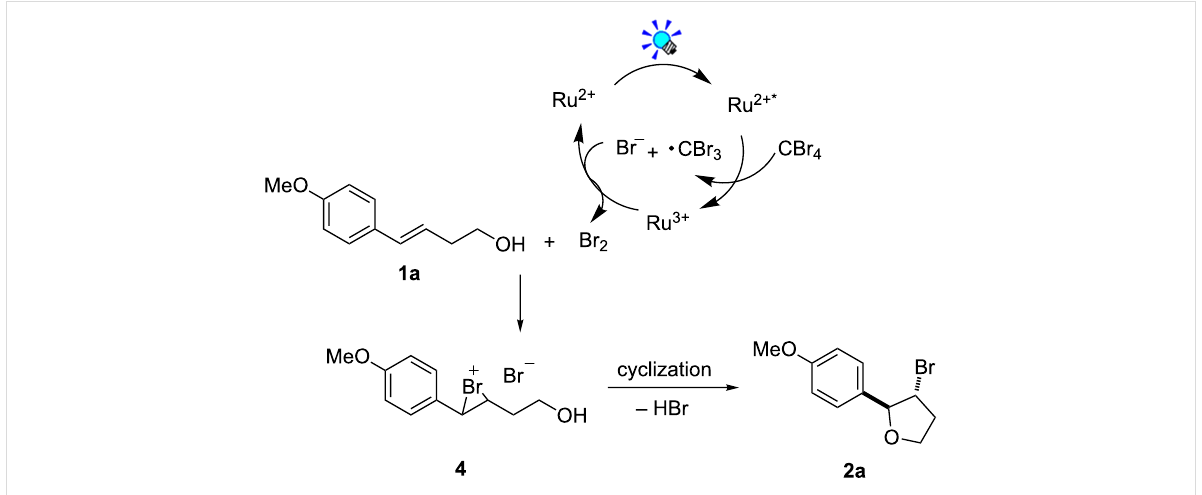
acetate. The combined organic layers were washed with brine, dried over anhydrous Na 2 SO 4 and concentrated. The residue was purified by flash column chromatography to give the final products 2